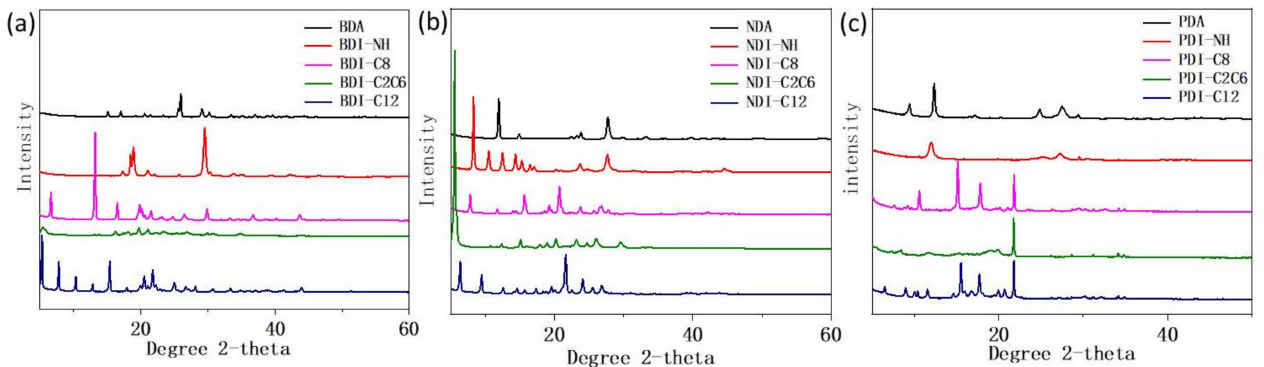
Figure 6. XRD spectra of: ( a ) BDI-, ( b ) NDI-, and ( c ) PDI-based